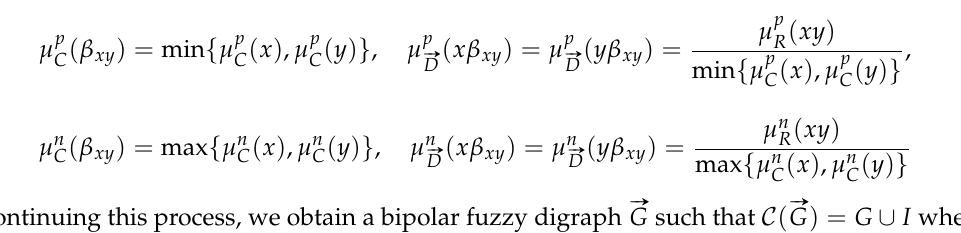
Figure 2.2: Bipolar fuzzy competition graph